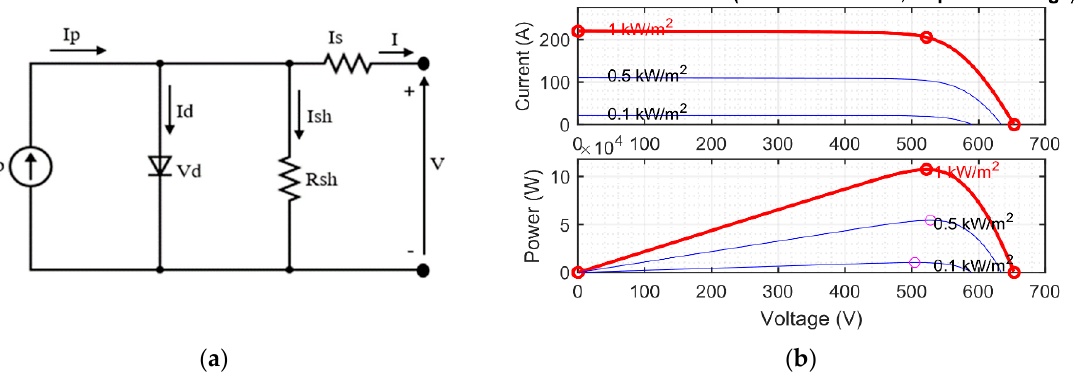
Figure 2. ( a ) Fundamental single diode equivalent circuit; ( b ) Current-Voltage and Power-Voltage characteristics of the considered PV array for different irradiance.